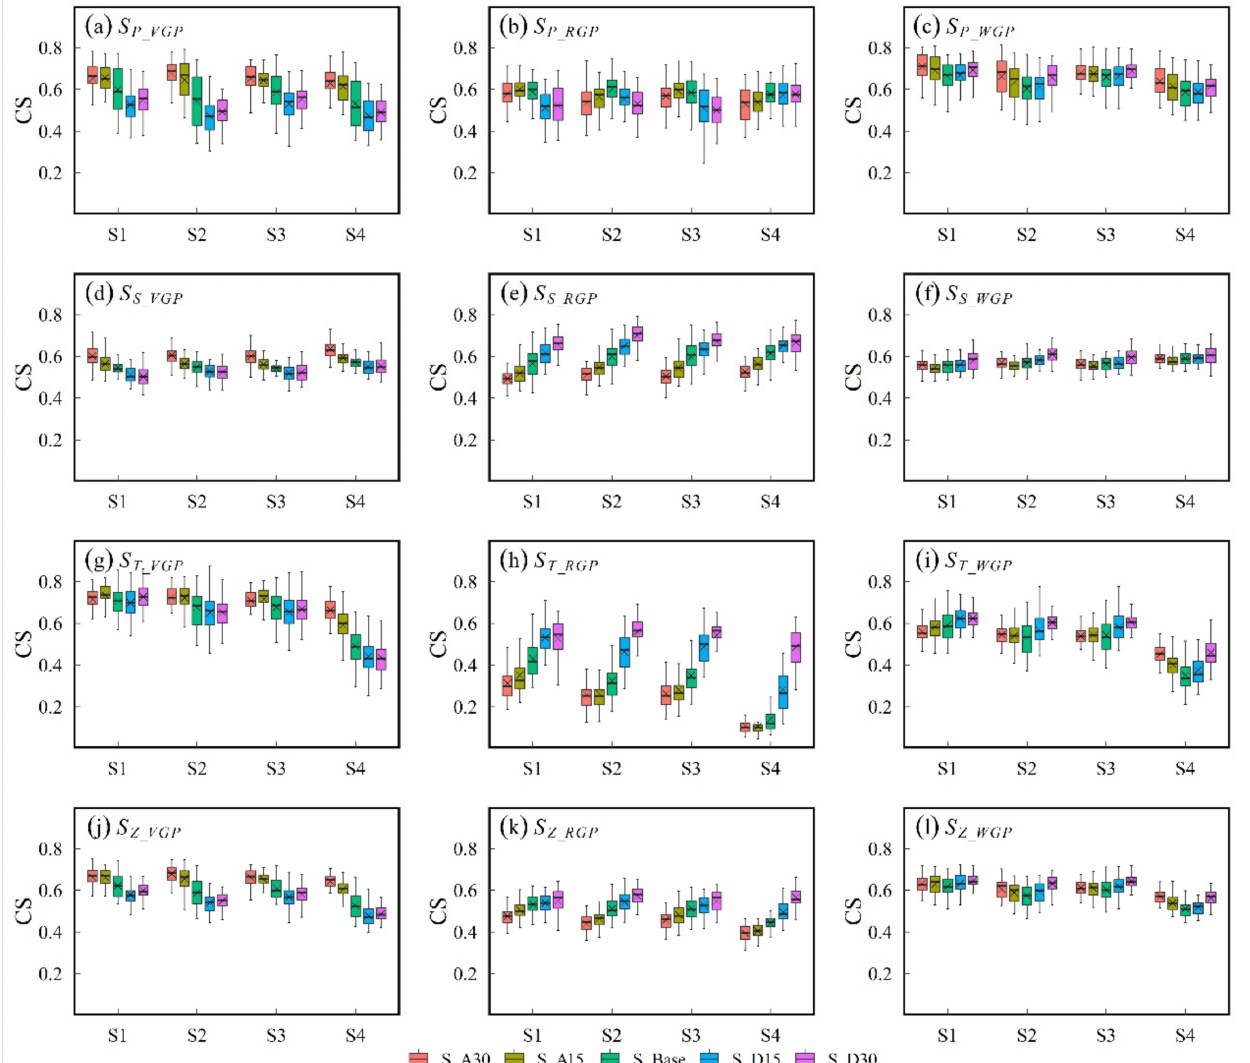
Figure 8. The climate suitability of maize for the vegetative growth period ( a , d , g , j ), reproductive growth period ( b , e , h , k ) and whole growth period ( c , f , i , l ) under different sowing dates in the NCP during the 2040s and 2080s under SSP245 and SSP585 (S1, S2, S3, and S4 are the SSP245_2040s, SSP245_2080s, SSP585_2040s, and